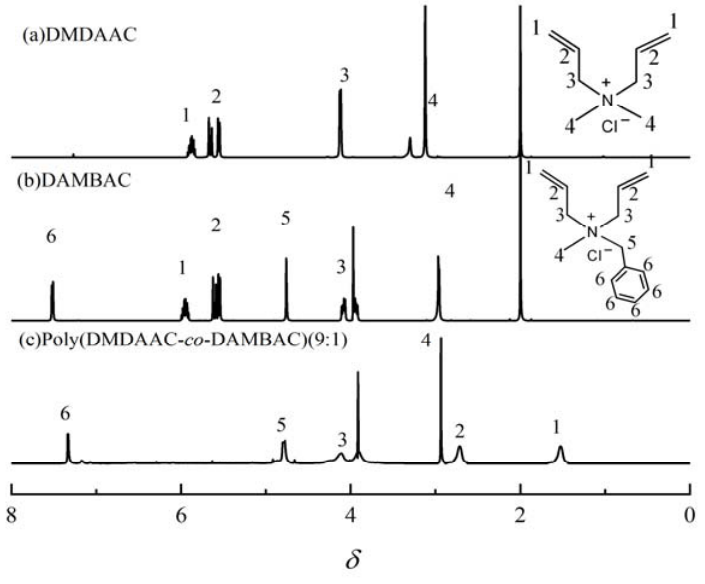
Figure 6. 1 H NMR spectra of DMDAAC ( a ), DAMBAC ( b ), and poly (DMDAAC ‐ co ‐ DAMBAC) (9:1) ( c ). 13 C NMR spectra of DMDAAC (a), DAMBAC (b), and poly (DMDAAC ‐ co ‐ DAMBAC)